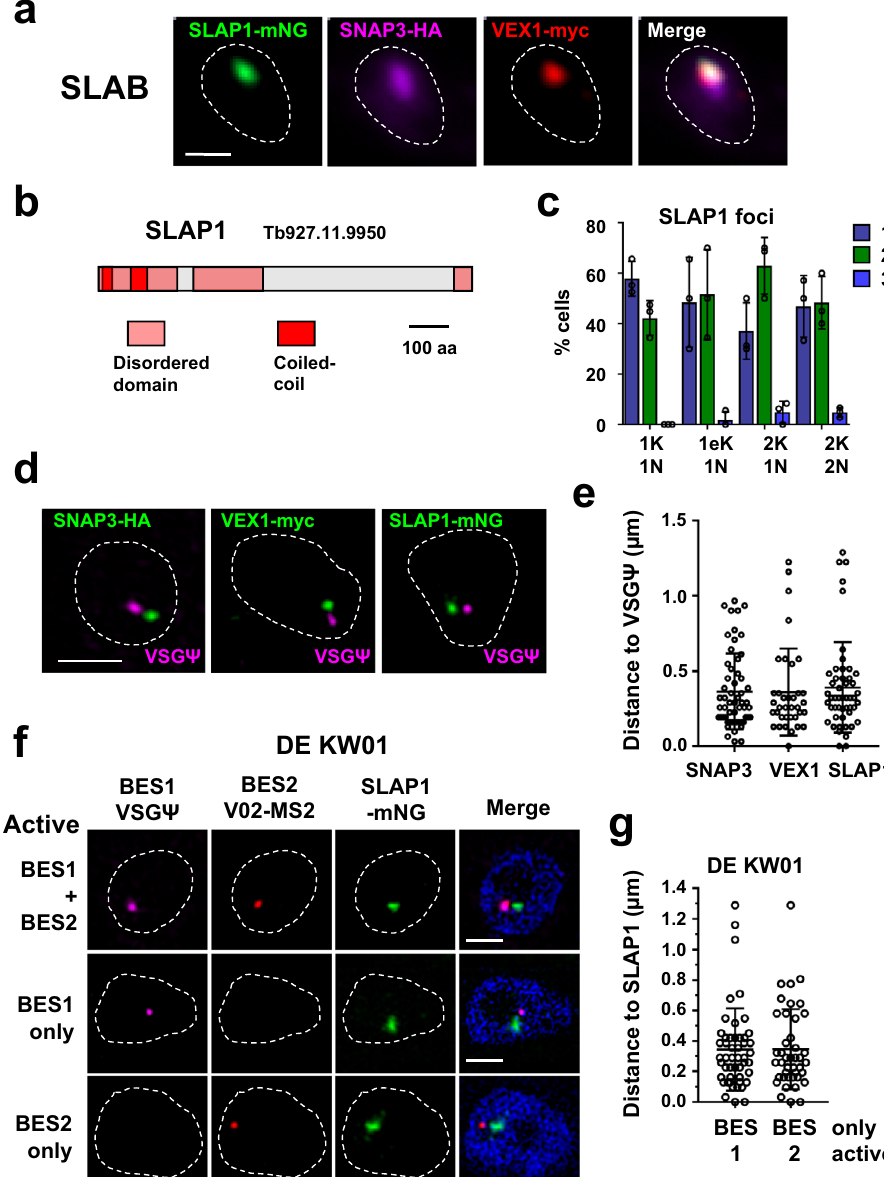
Fig. 2 Identi fi cation of a Spliced Leader Array Body (SLAB) which frequently associates with the active ES. a Fluorescence microscopy imaging of a triple epitope-tagged BF T. brucei cell line expressing the SLAB components SLAP1, SNAP3 and VEX1. Signals in the nucleus (dashed line) correspond to mNG::SLAP1 (SLAP-mNG, green), SNAP3::6xHA (SNAP3-HA, magenta) and VEX1::12xmyc (VEX1-myc, red). Scale bar = 1 μ m. b Schematic of SLAP1 protein motifs identi fi ed using PFAM and disordered domains with PONDR. c Quantitation of the percentage (%) of BF T. brucei cells with